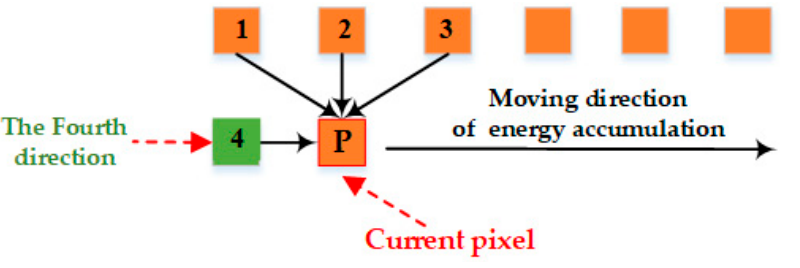
Figure 4. Schematic diagram of energy accumulation by improving energy guidelines.